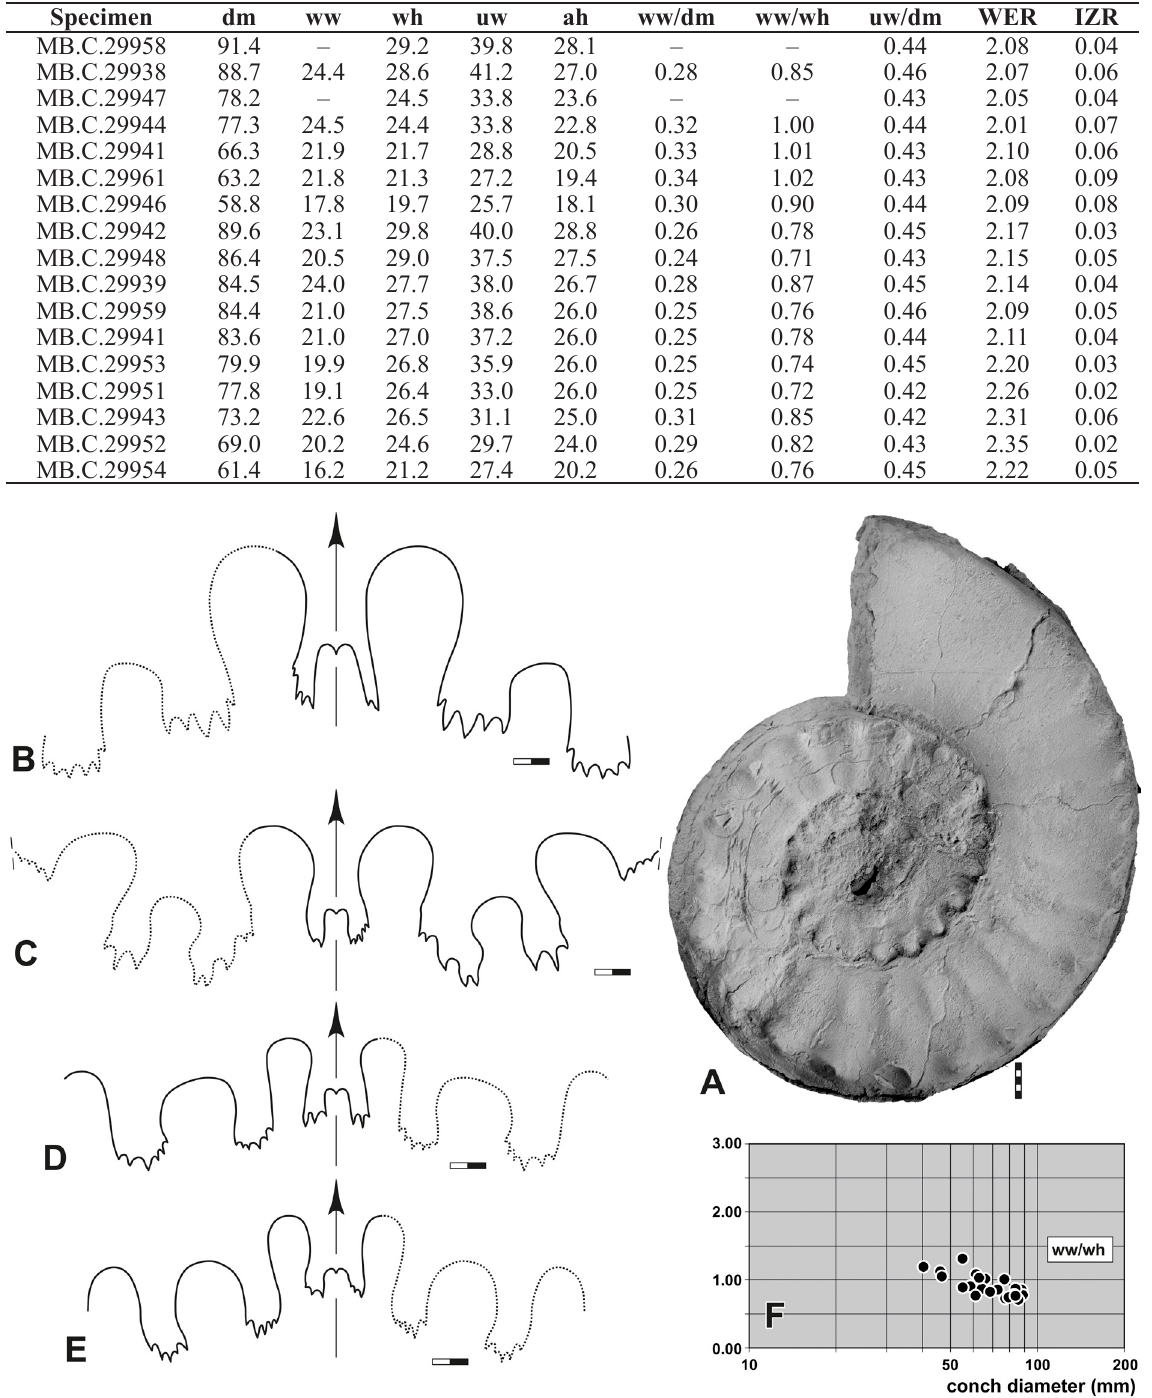
Fig. 43. Clivotirolites decoratus Korn & Hairapetian gen. et sp. nov. A . Lateral view, paratype MB.C.29958, section G, float. B . Suture line, paratype MB.C.29938, at 17.8 mm wh. C . Suture line, paratype MB.C.29944, at 15.6 mm wh. D . Suture line, holotype MB.C.29941, at 13.2 mm wh. E . Suture line, paratype MB.C.29946, at 13.0 mm ww, 11.2 mm wh. F . Whorl profile proportions. Abbreviations: see Material and methods. Scale bar units =